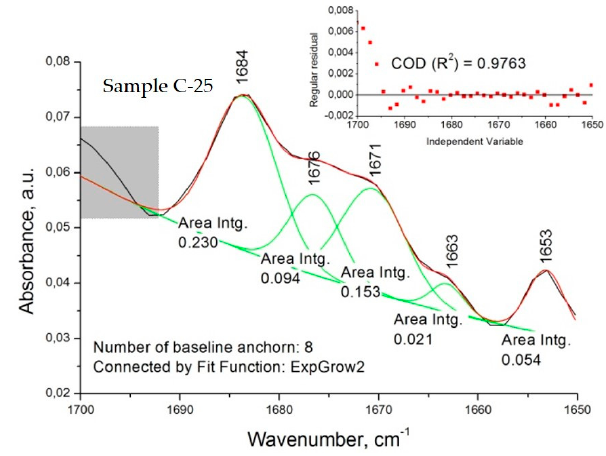
Figure 6. An example of deconvolution analysis carried out on Sample C-25 spectrum.